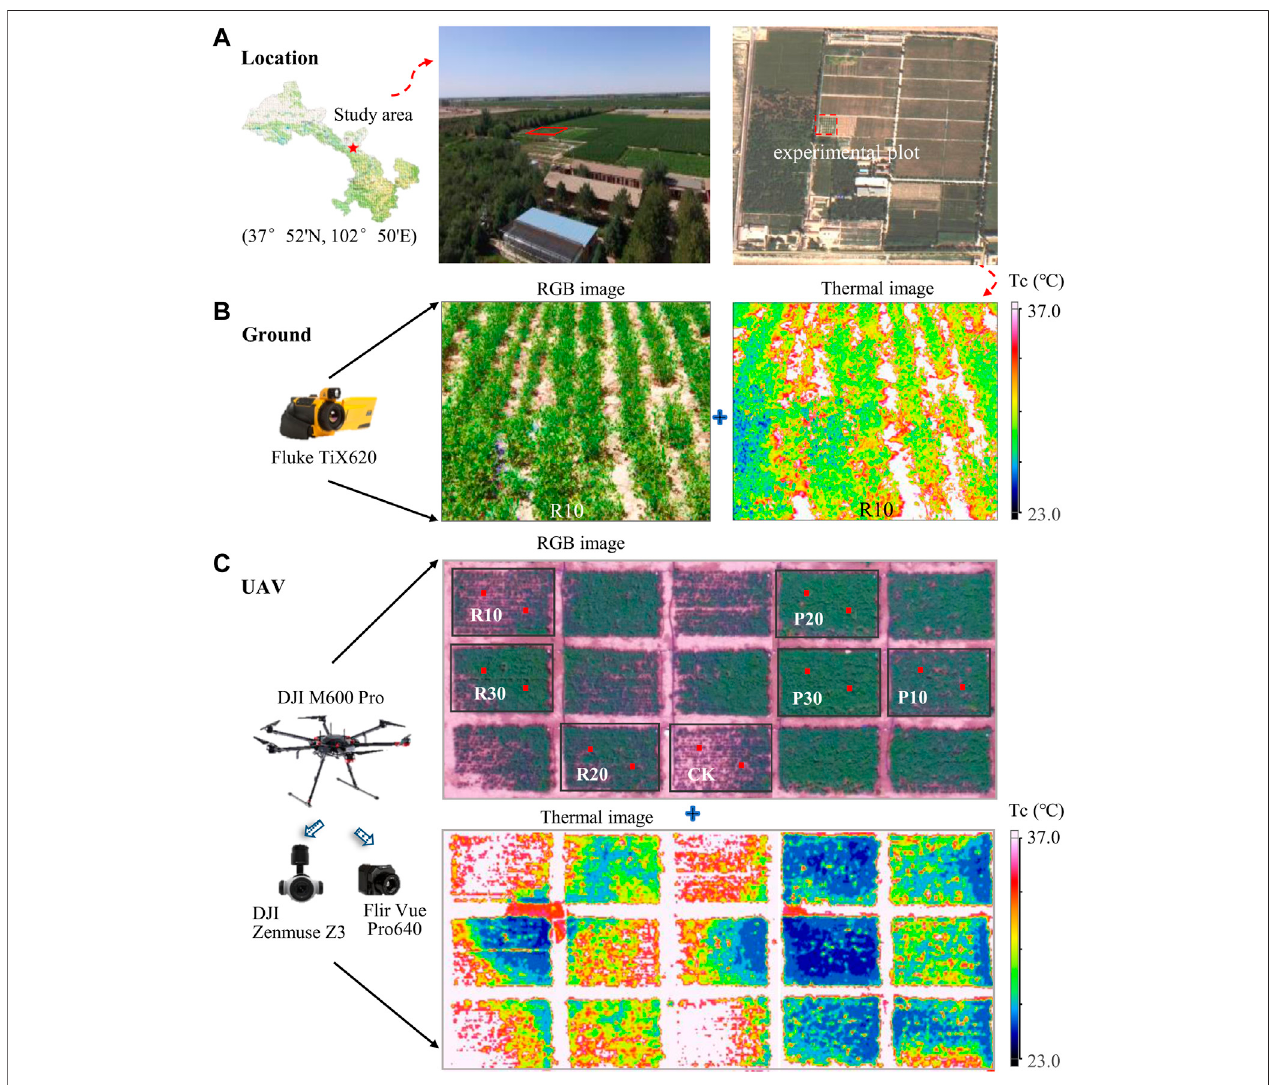
FIGURE 1 | (A) Geographic location of the study area and details of the experimental plot layout for the alfalfa irrigation treatments at (B) proximal and (C) UAV scales.Forexample,R10representstheirrigationquotaat10 mmusingtraditionaldripirrigation.Adetaileddescriptionofallthetreatments ispresentedin Table1 .The red dots in UAV-based RGB image were the locations of soli moisture measuring tubes. The images were collected at 13:00 on July 26, 2018.